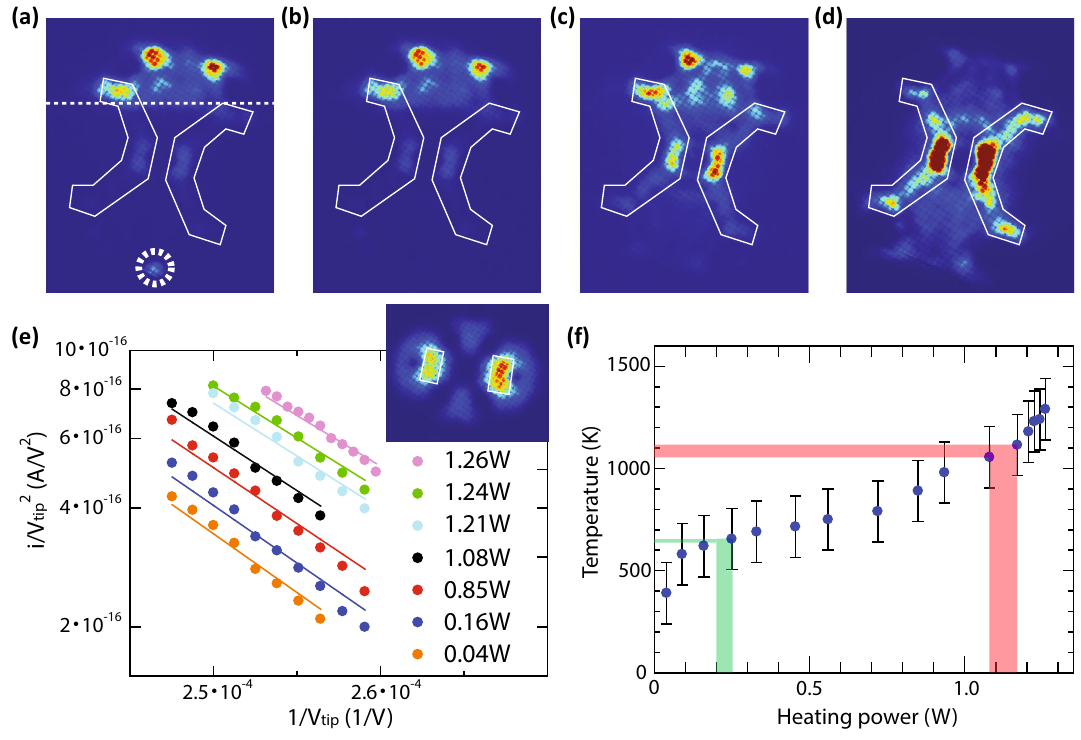
Figure 4. Evaporation of strongly-bound molecules by heating. ( a )–( d ) A series of FEM images with increasing temperature of the tip. The temperatures are sequentially increasing. The image in ( a ) was taken at room temperature. The emission areas of the tungsten carbide are highlighted by white lines. In ( a ), a peculiar molecule emission pattern is marked by a dashed circle. ( e ) Heating power dependence of FN plots. The inset shows an FEM image of a clean tungsten surface. The signals for the FN plots are taken from (310) type facets as indicated by the rectangles in the inset. The vertical axis in figure ( e ) is signal i over the V 2 tip on a logarithmic scale. The signal i used in figure ( e ) is the total yield of electron emission from the right rectangle in the inset. The horizontal axis is 1 / V tip . The temperature of the tip was extracted by fitting theoretical FN curves given in the references 18,19 onto experimentally obtained FN plots at each heating power. There are three fitting parameters: a temperature, a work function and a voltage conversion factor C L , where the applied voltage V tip can be converted to a local electric field F L via F L = C L V tip . The unit of F L is V/nm. As described in the caption in Fig. 2, C L is expressed by C L = 1 kr . In this series of experiments, the tip radius r was 165 nm. The parameter k was determined by a curve fitting using the FN plots at room temperature. The resulting value of k was 6.91 − 4 and hence the value of C L was 8.77 × 10 . For the work function, the previously obtained value of 4.45 eV was used 20 . Then the temperature was determined for the FN plots at each elevated heating power via the curve fittings. The resulting FN curves are shown as solid lines in figure ( e ) by using the same colour code as those of the corresponding FN plots. ( f ) Plots of temperature versus heating power. The temperatures were extracted from the FN plots from both rectangle areas in ( e ) and were calculated by taking an average of the two cases. The width of the colour bands indicate the ranges of heating powers where the molecule patterns (green bands) and the buffer layer (red bands) disappeared.